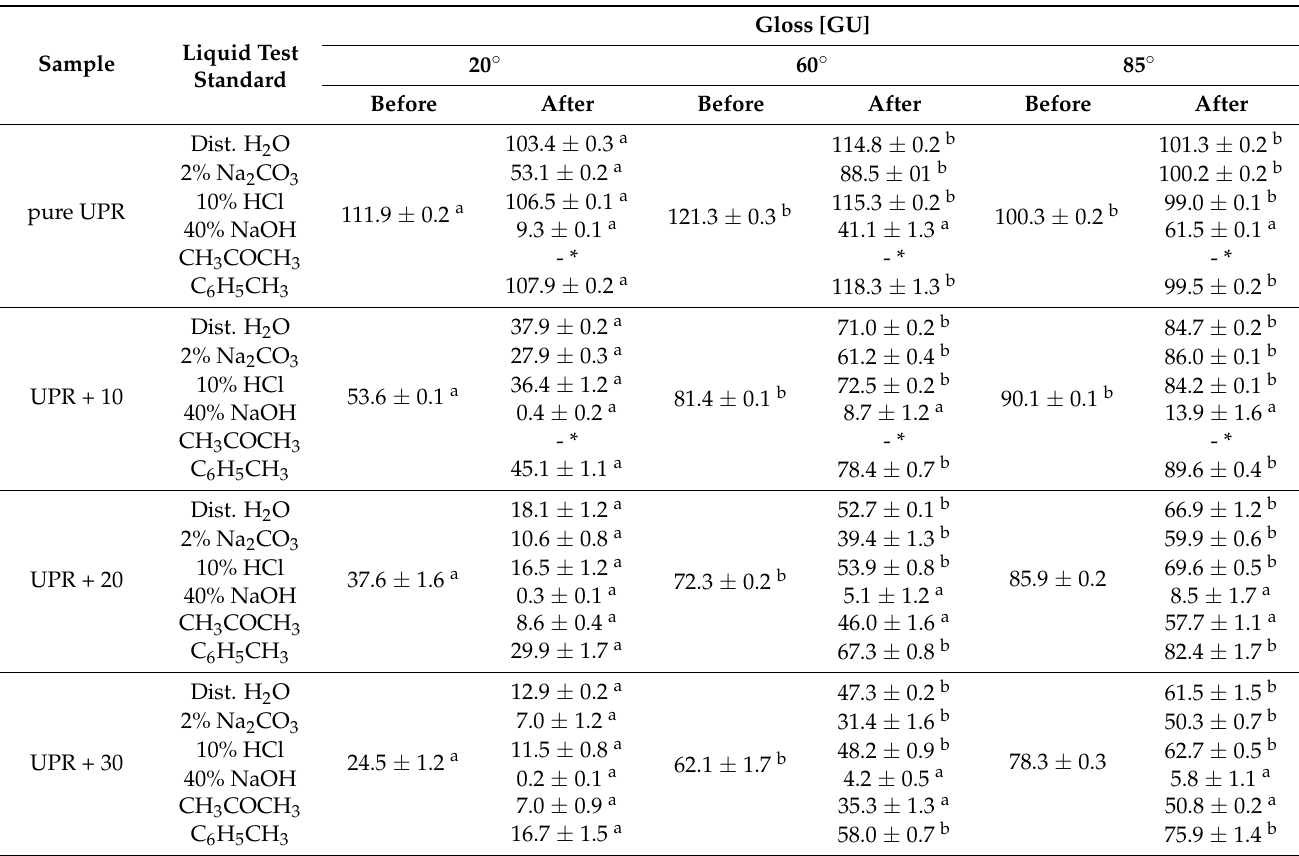
Table 4. Gloss measurement data of the UPR/PSP composites before and after the immersion test (mean ± SD; n = 10).